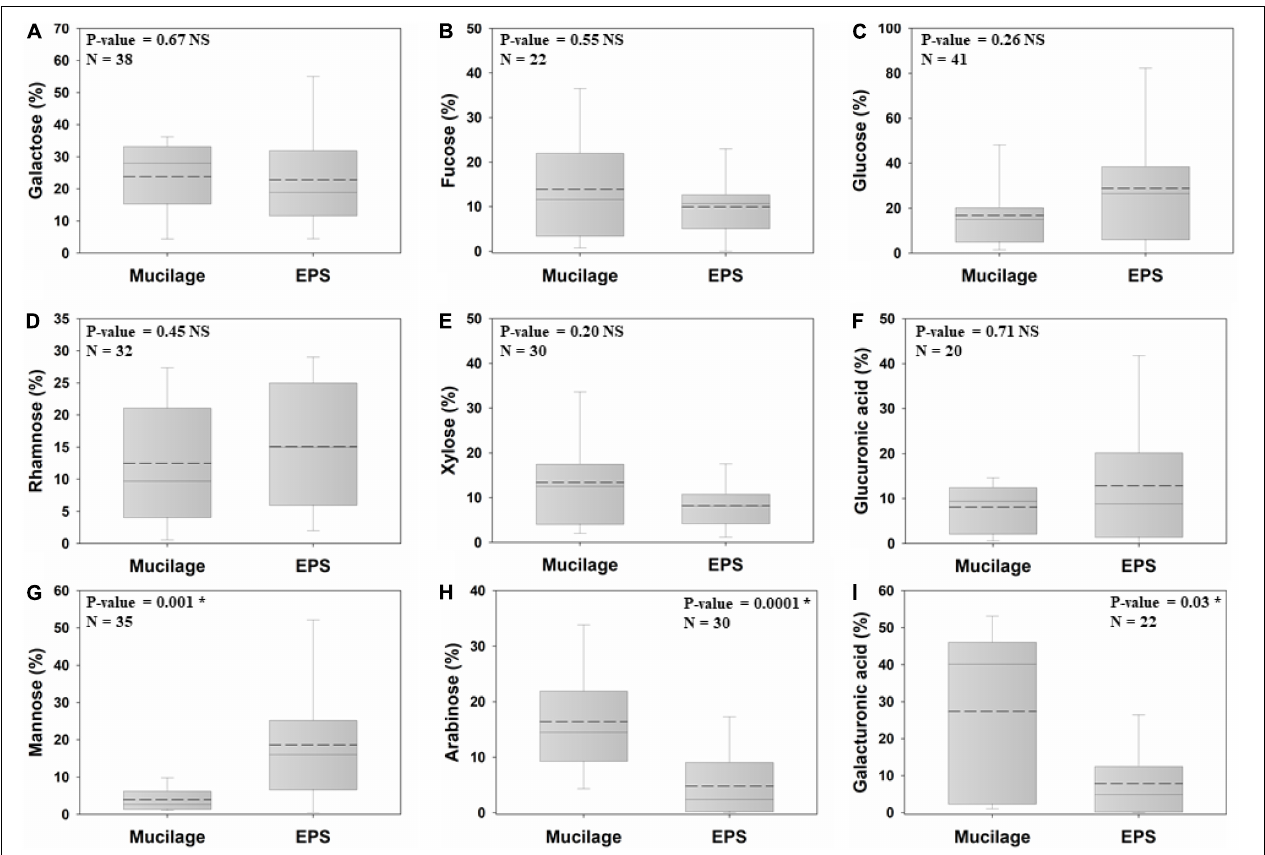
FIGURE 3 | Comparison of the proportion of mucilage and EPS galactose (A) , fucose (B) , glucose (C) , rhamnose (D) , xylose (E) , glucuronic acid (F) , mannose (G) , arabinose (H) , and galacturonic acid (I) , using Independent Samples at the significance level of 0.05. The dashed and solid lines on each box indicate the arithmetic mean and median, respectively. The box defines the 25th and 75th percentiles. NS and * indicate a non-significant and significant difference, respectively. N: number of data